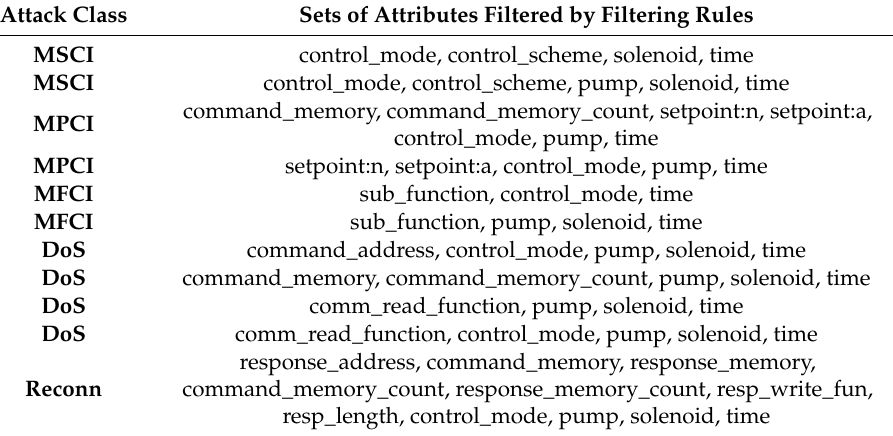
Table 5. Filtered Results of Command Injection